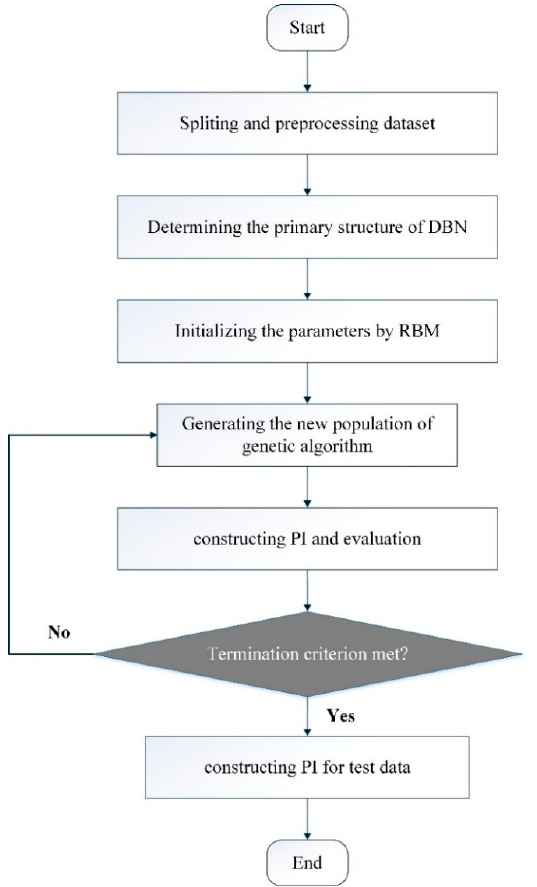
Figure 5. The flowchart of the DBN-based LUBE method.